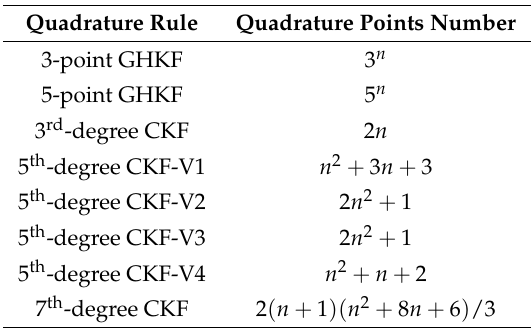
Table 1. Comparative quadrature points for different rules used in this paper. GHKF: Gauss–Hermite Kalman filter and CKFs: Cubature Kalman filters (3 rd -degree, multiple versions of 5 rd